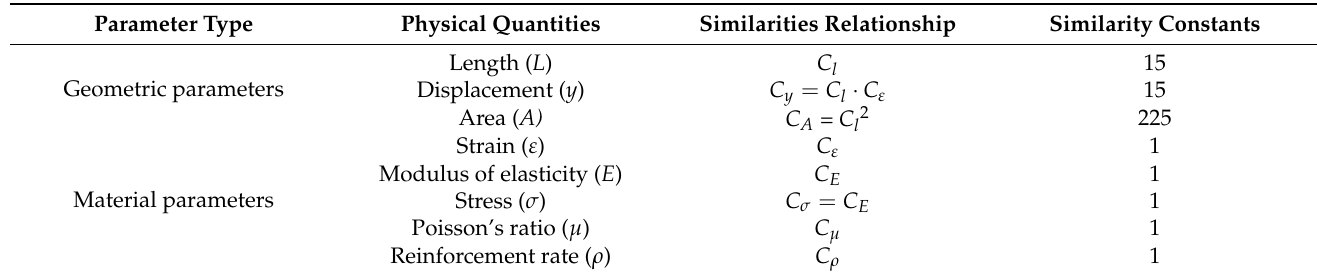
Table 2. Similarity ratio of model test.